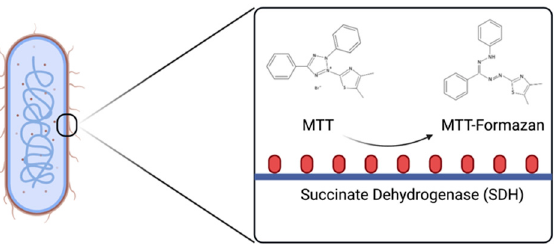
Figure 1. Basic mechanism of the reduction of MTT to MTT-Formazan on bacteria. Created with BioRender.com (https://app.biorender.com/). Last accessed: 9 October